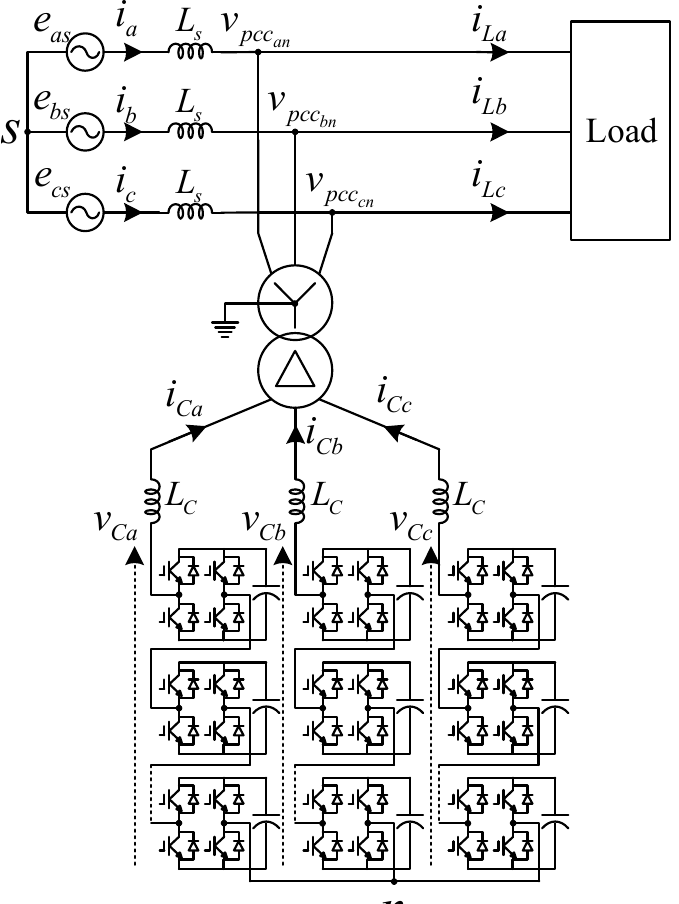
Figure 1. Wye-connected cascaded H-bridge (CHB) converter-based static synchronous compensator (STATCOM) system.